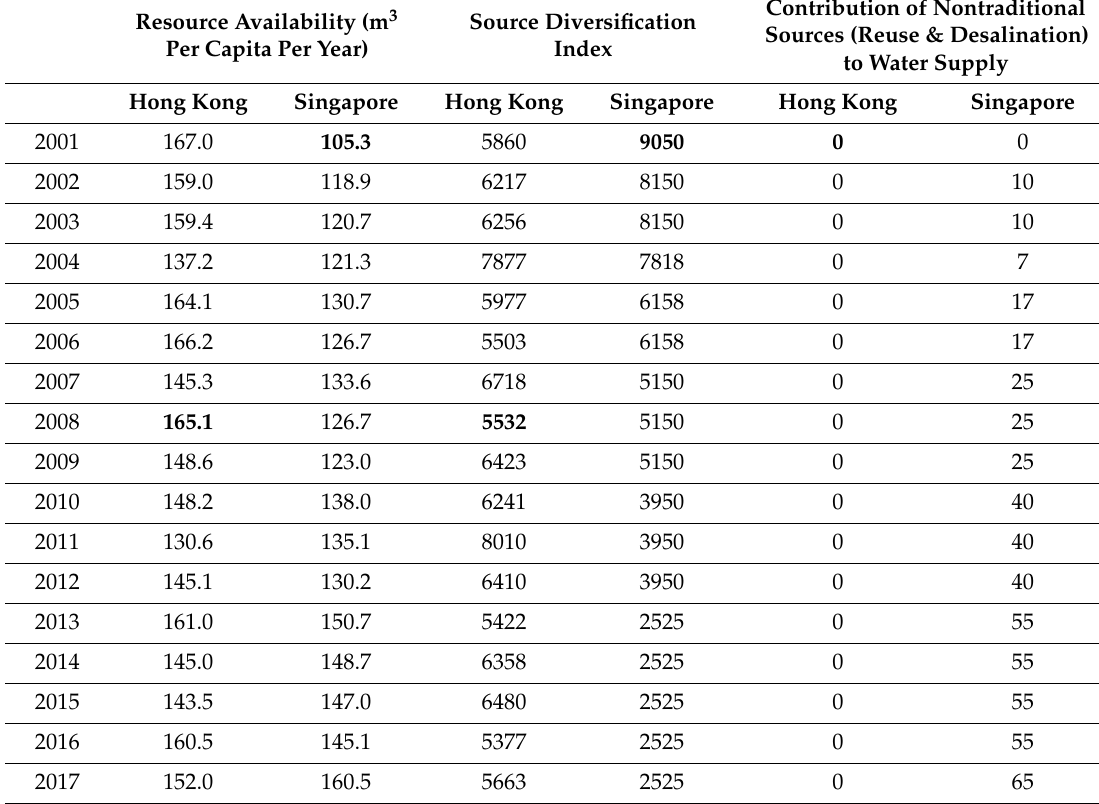
Table 3. Water security indicators in Hong Kong and Singapore between 2001 and 2017.